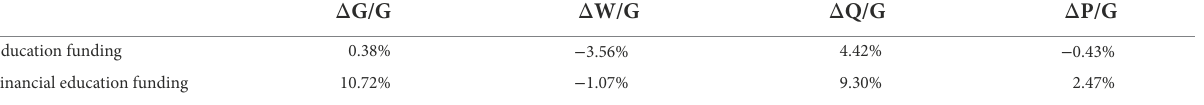
TABLE 8 Gap incremental decomposition results.